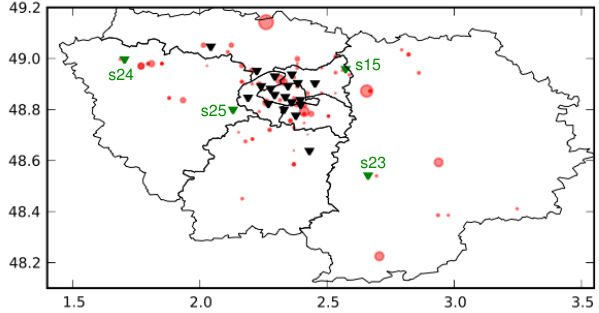
Fig. 4. Measurement stations (triangles), and main point sources, for NO. The circles areas are proportional to the sources emission rate. The black triangles are urban stations, green triangles are peri- urban and rural stations (the names of these stations also are indi-